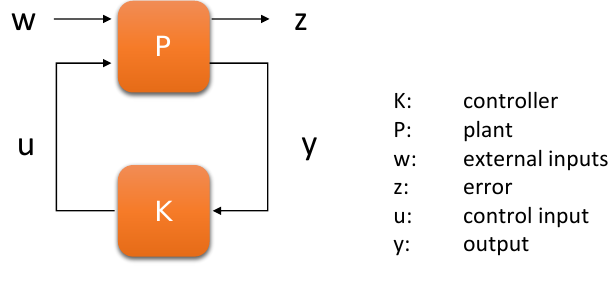
Figure 8. General control configuration ([27], p.